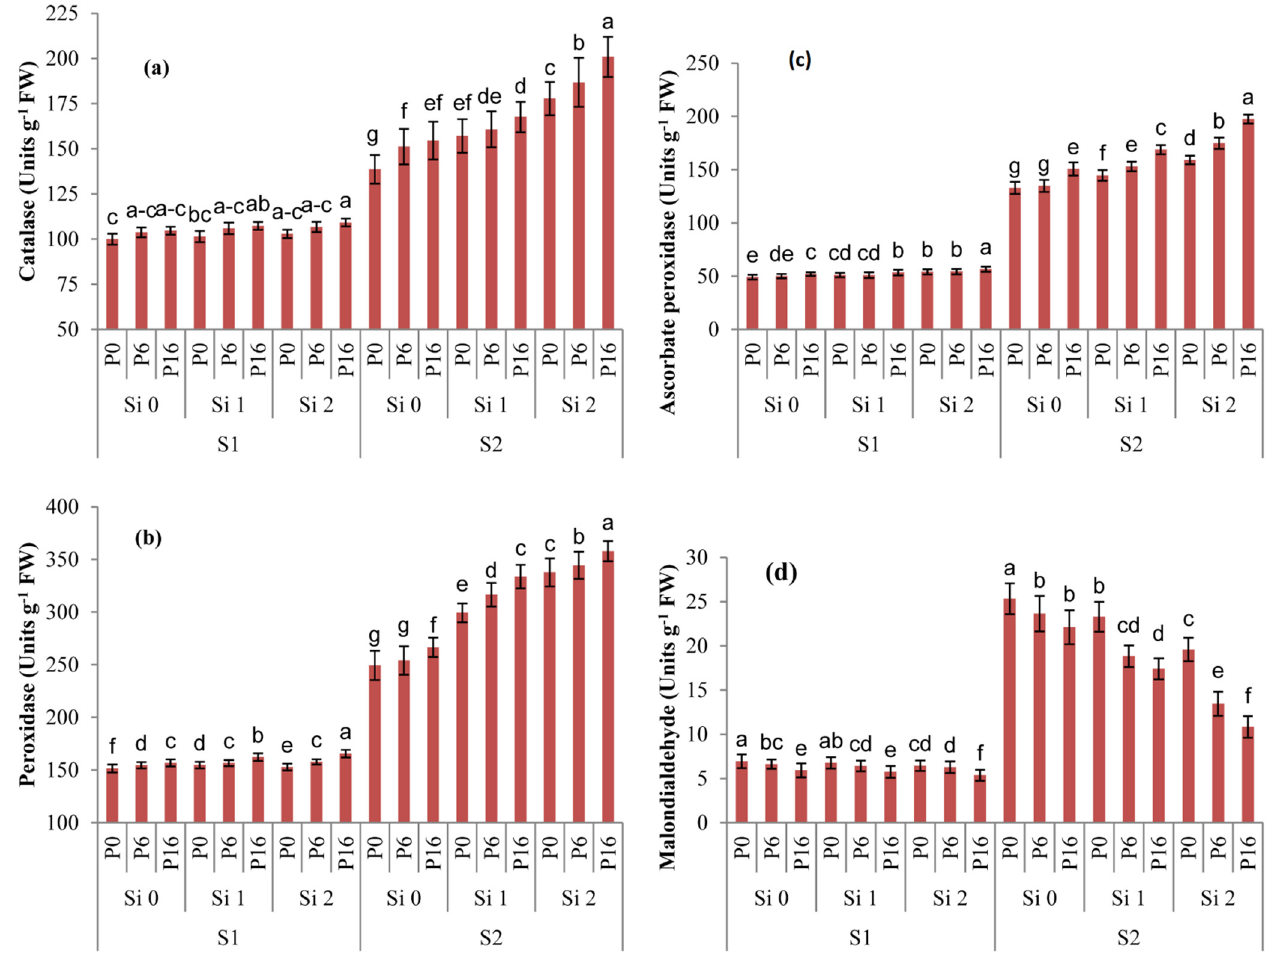
Figure 1. Influence of silicon (Si) and plant growth promoting bacteria (PGPR) applications on oxidative metabolism of mung bean crop under salinity stress. Oxidative metabolism was examined by antioxidants including catalase ( a ), ascorbate peroxidase ( b ), peroxidase ( c ) and lipid peroxidation level that was estimated by malondialdehyde pools (MDA) ( d ). The following are the treatment details on the x axis: P0 = Un-inoculated control, P6 = E. cloacae, P16 = B. drentensis, Si 0 = 0 kg Si ha − 1 , Si 1 = 1 kg Si ha − 1 , Si 2 = 2 kg Si ha − 1 , S1 = Saline irrigation at 3.12 dS m − 1 , S2 = Saline irrigation at 7.81 dS m − 1 . The Si was applied by foliar spray in a sequence of three weeks after sowing (1 kg ha − 1 ) and at flowering stage 2 kg ha − 1 , while PGPR was applied by seed inoculation using standard protocol. Graphs represent the mean ( n = 3) ± SE. Different letters above each bar are the indicative of statistical difference between treatments ( p ≤ 0.05).